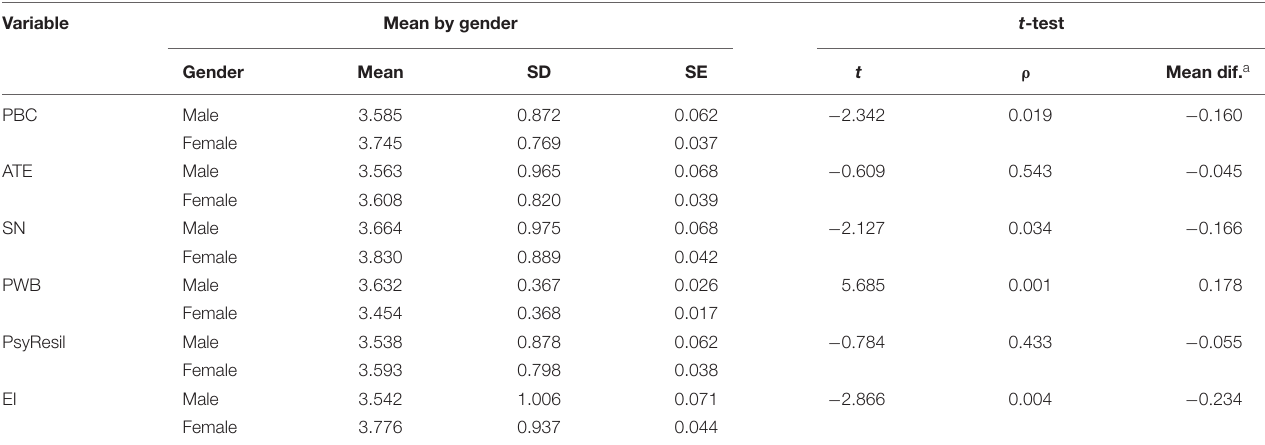
TABLE 6 | Variables’ mean by gender.